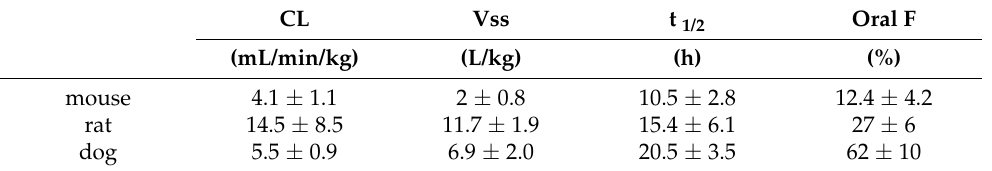
Table 4. Pharmacokinetic profile of compound 4 in mouse, rat and